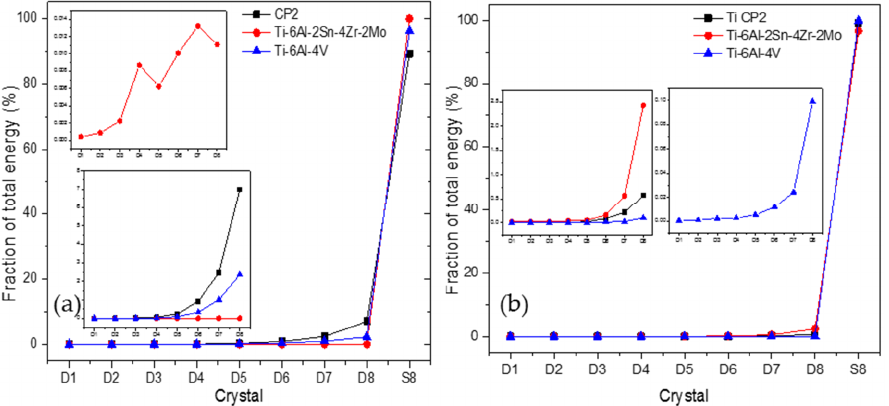
Figure 5. Energy dispersion plot for ( a ) NaCl and ( b ) H 2 SO 4